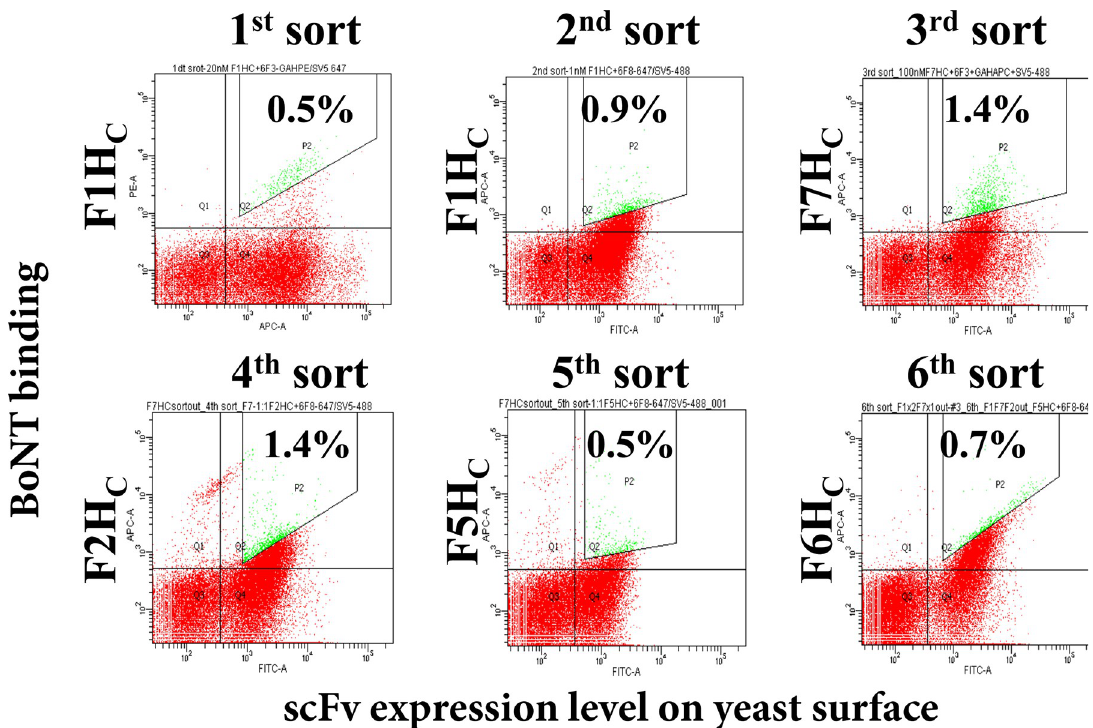
Fig 3. Dot plots of FACS of the mAb 28H4 scFv yeast displayed library stained with a single subtype for each round of sorting. The 28H4 library was sorted for six rounds sequentially staining with different BoNT subtypes BoNT/F1H C (Rounds 1 and 2) BoNT/F7H C (Round 3) BoNT/F2H C (Round 4), BoNT/F5H C (Round 5), and BoNT/F6H C (Round 6). Each dot represents a single yeast with the BoNT subtype used for staining and the BoNT binding fluorescence shown on the y-axis and the level of scFv yeast surface display on the x-axis. The population gated for sorting and the percent of the total population sorted is shown with the gated yeast colored green.